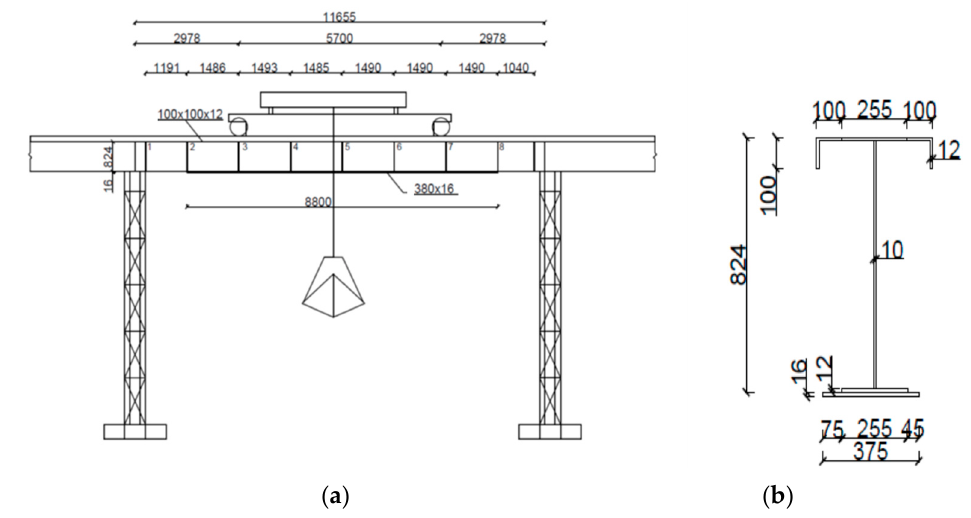
Figure 1. Diagram: ( a ) crane beam, ( b ) cross ‐ section of the beam.